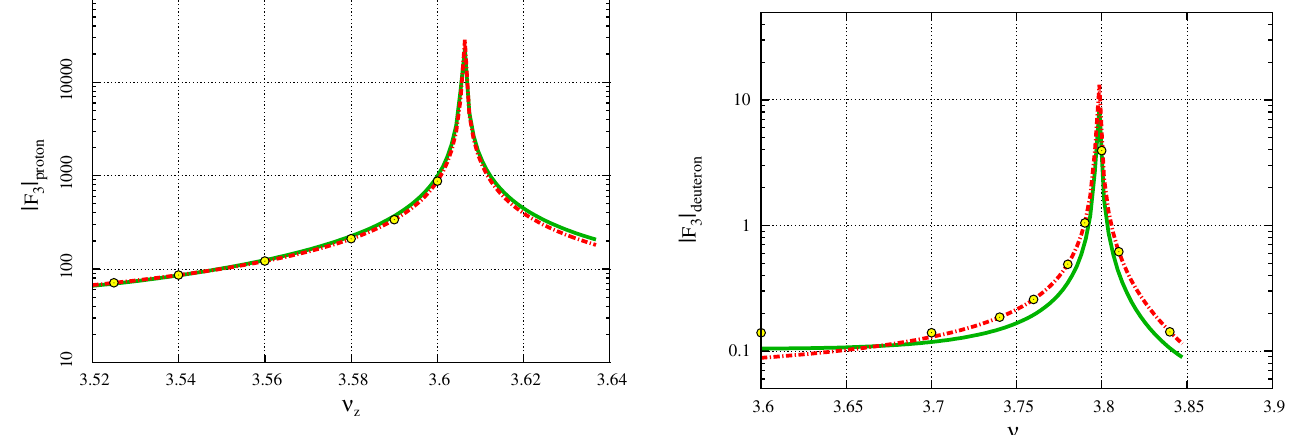
FIG. 4. Graph of j F 3 j (for deuterons, at the location of the rf . z dipole in COSY) plotted against the vertical betatron tune (cid:5) The deuteron momentum is p ¼ 1 : 85 GeV =c . The solid curve is a numerical calculation. The dot-dashed curve is the experimen- tal fit to the data published by the authors of [5].